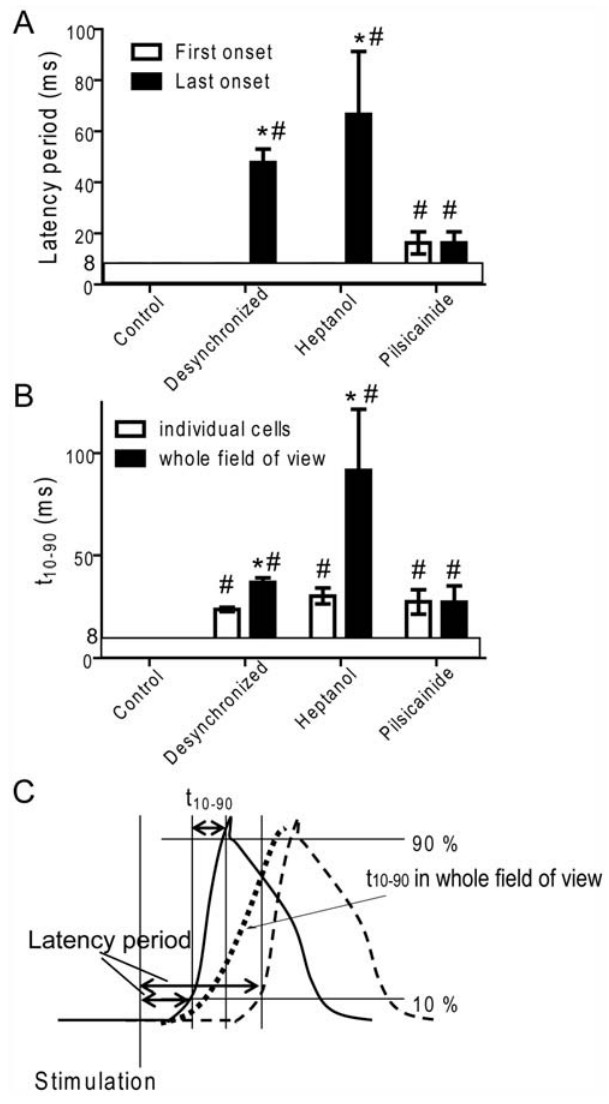
Figure 6. Latency ( A ) and the rate of rise ( B ) of the action potential under various conditions. Control : control muscles (n=22); Desynch : muscles showing visually discernable desynchroni- zation in Ca 2 + transients ( . 40 ms) after the pacing protocol (n=6); Heptanol : with 2 mM heptanol (n=5); Pilsicainide : with 40 m M pilsicainide, muscles were stimulated locally (n=4). A. Action potential latencies in cells with the first (open column) and last onsets (filled column) in the field of view were determined. *significant difference from the first onset. # significant difference from control. B. Rates of rise of the action potentials (t 10–90 ) in randomly chosen individual cells (mean of 10 cells for each preparation were averaged for n preparations, open column) and in the whole field of view (filled column). *significant difference from individual cells. # significant difference from control. Data are mean 6 S.E.M. P , 0.05. Note that the responses faster than , 8 ms were not distinguishable. C . A schematic illustration of determinations of the action potential latency and the rate of rise of the action potential.